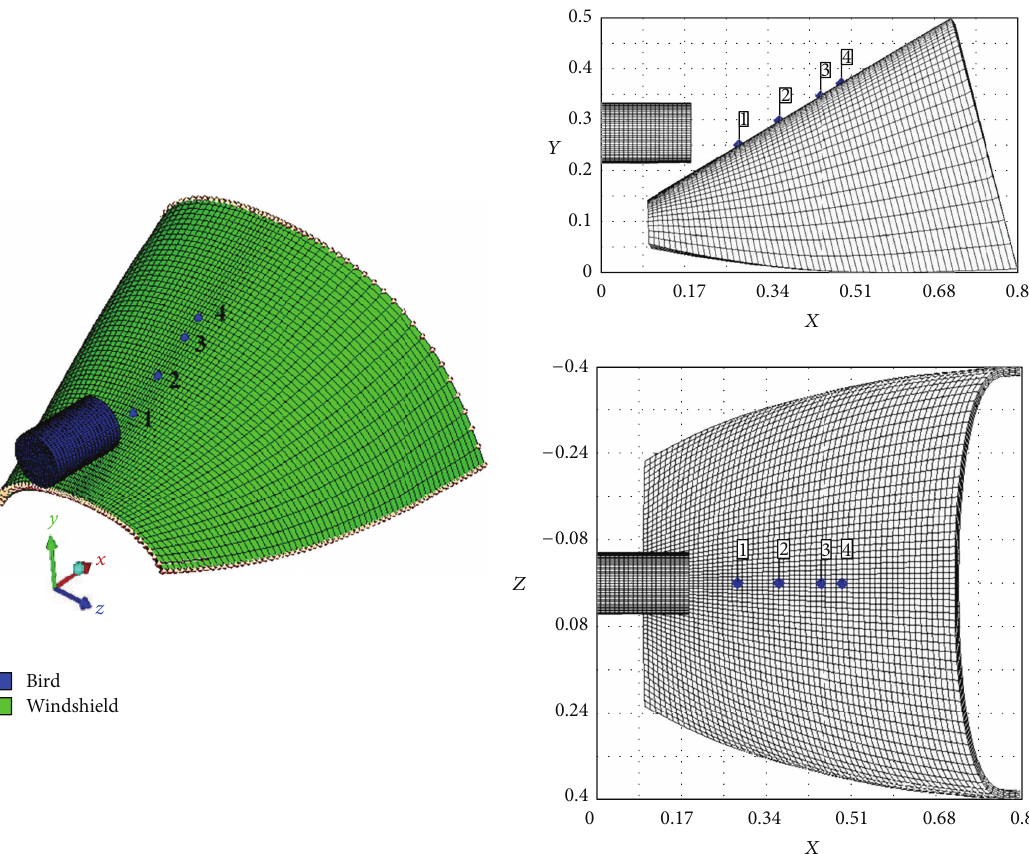
Figure 6: Finite element model of bird impact on windshield: Isometric view (Left) Side and top views (Right).